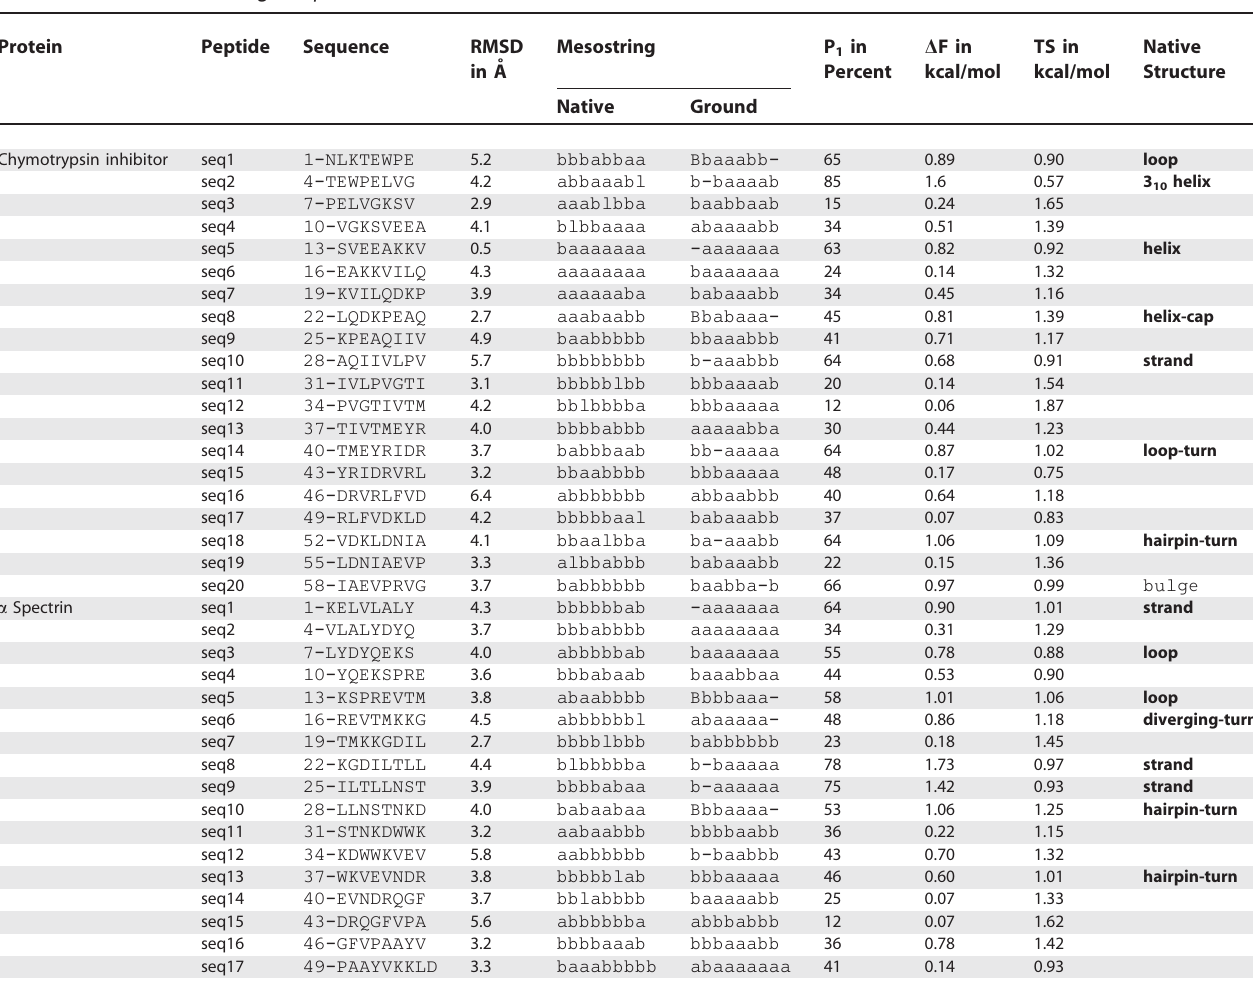
TS in Native kcal/mol Structure